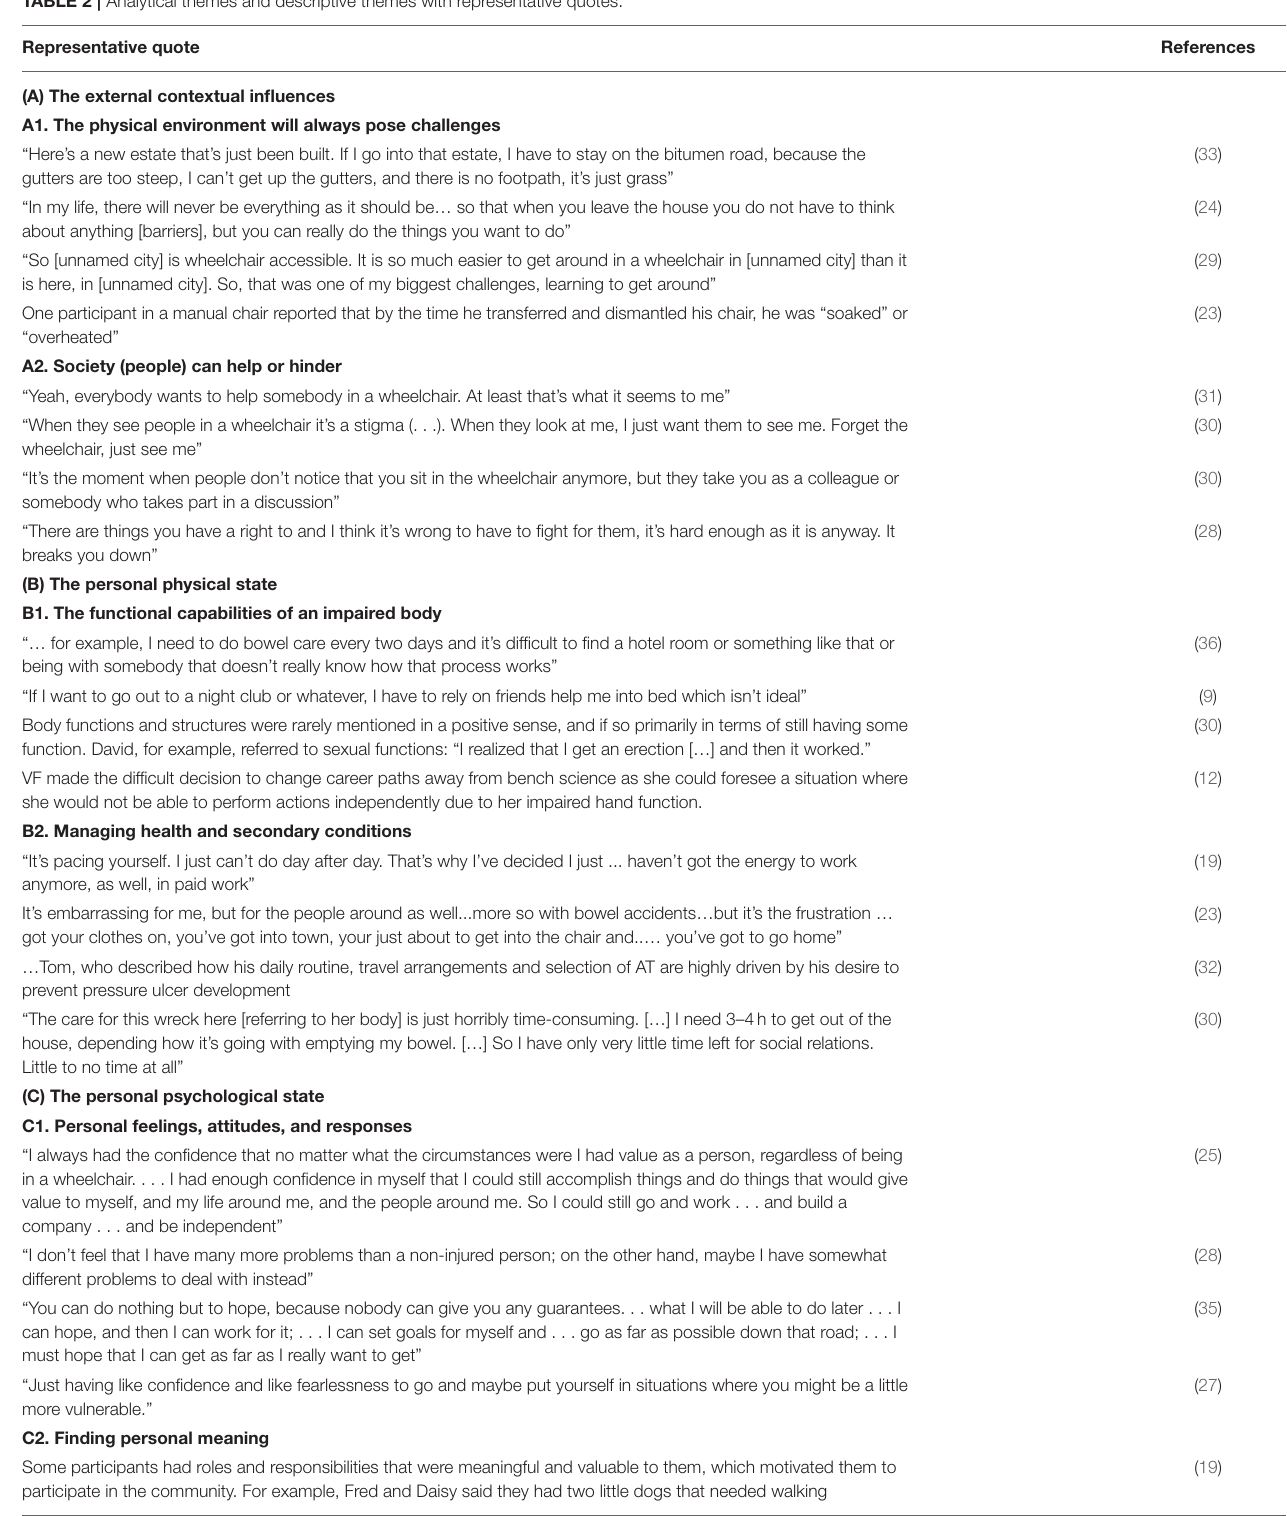
TABLE 2 | Analytical themes and descriptive themes with representative